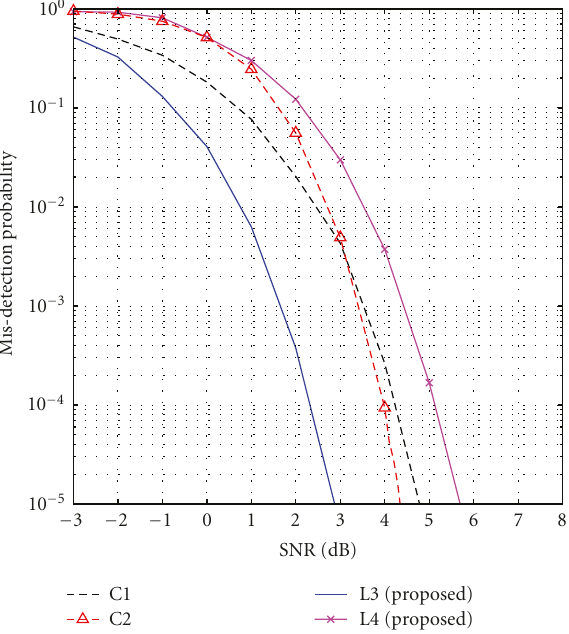
Figure 6: Receiver operating characteristics of the proposed and conventional detectors under severe frequency o ff sets ( f m T s = 0 . 2).